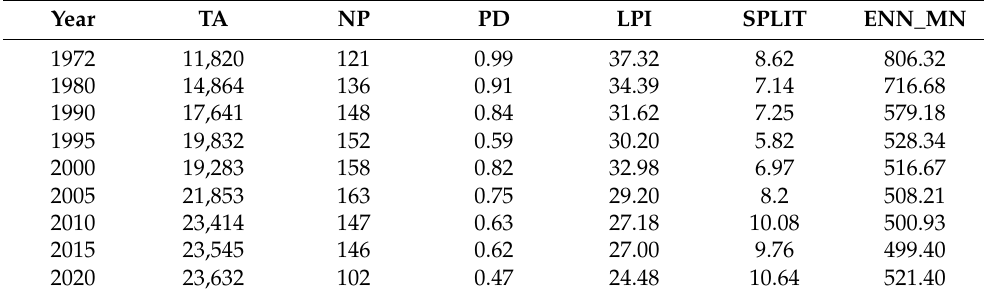
Figure 5. Evolution map of the centre of gravity of construction land in Hong Kong from 1972 to 2020. Table 8. List of Landscape Pattern Indices of construction Land in Hong Kong in the Study